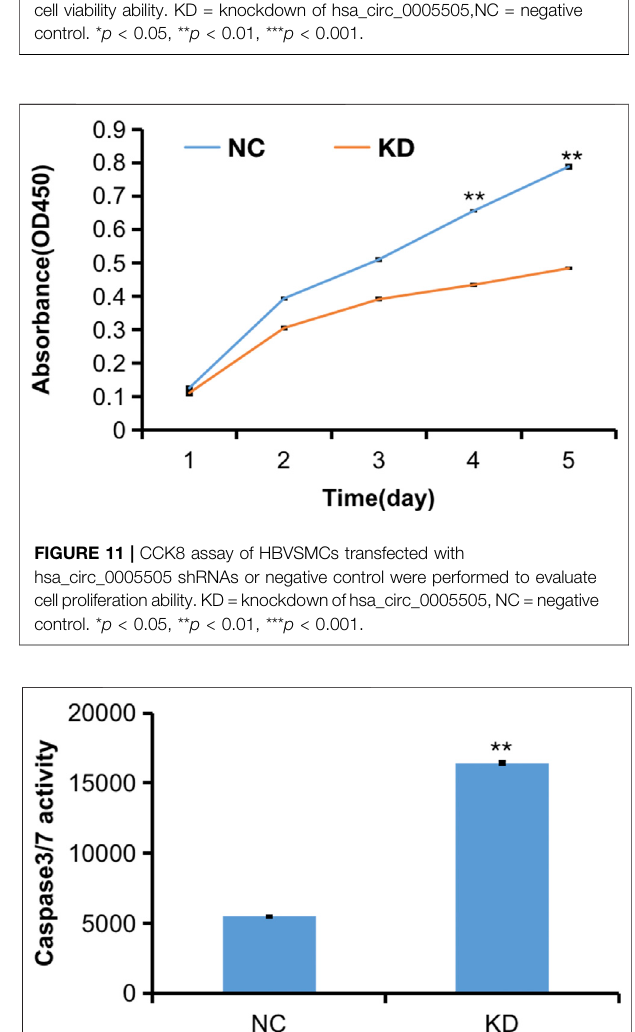
FIGURE 10 | MTT assay of HBVSMCs transfected with hsa_circ_0005505 shRNAs or negative control were performed to evaluate